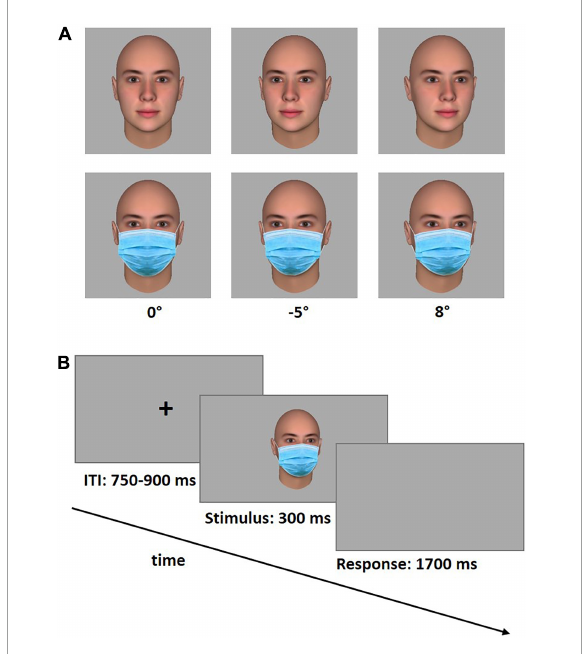
FIGURE1 Stimulus examples in three different viewing angles (0 ◦ , –5 ◦ , and 8 ◦ ), with and without face mask (A) and schematic time line of the gaze task (B) . The task consisted of a variable inter-stimulus interval (ITI), followed by a stimulus face (300 ms), which was then replaced with a response window (1,700 ms). Participants responded whether or not the stimulus face was looking at them via two orthogonally arranged custom-made response